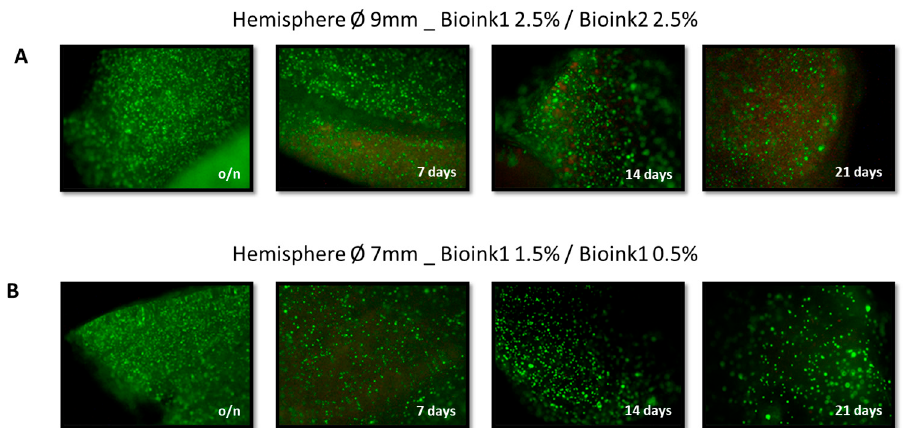
Figure 6. Evaluation of viability with fluorescein diacetate and ethidium bromide of bioink1 2.5%/bioink2 2.5% ( A ) and bioink1 1.5%/bioink1 0.5% ( B ) samples after O / N , 7, 14 and 21 days of culture (4X magnification).